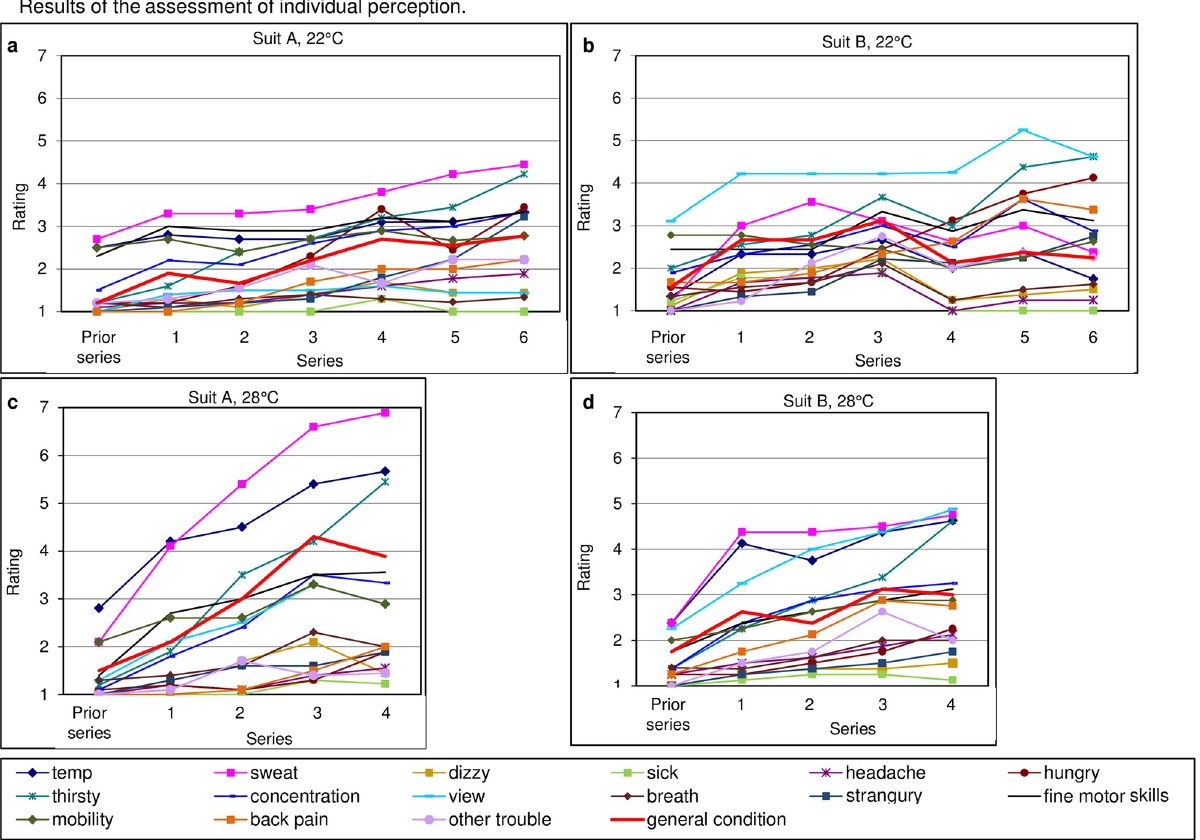
Fig 6. Results of the assessment of individual perception. Participants rated their individual comfort and general condition in an assessment sheet prior to and after the task series from 1 (= low interference) to 10 (= high interference, cause for